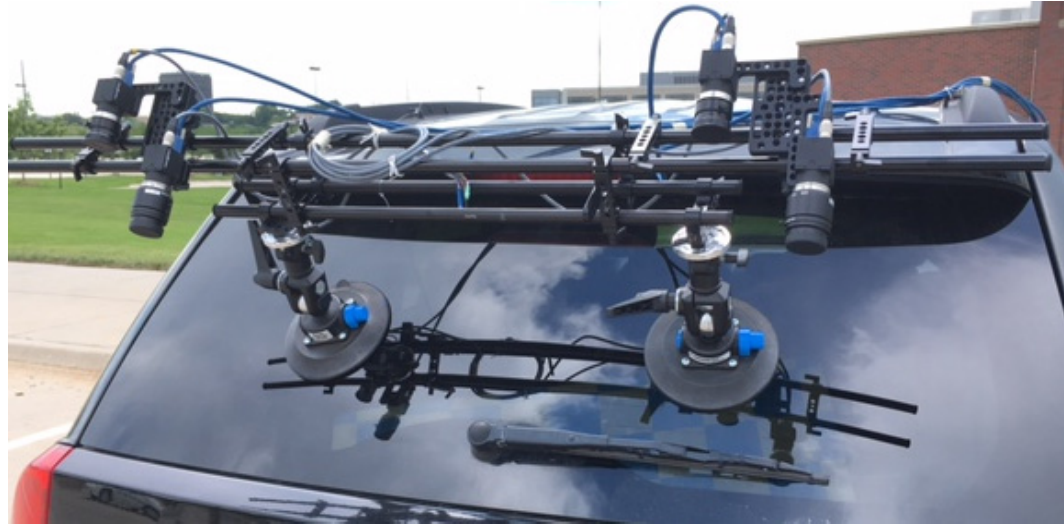
Figure 2. Multi-view camera system mounted on a road vehicle.